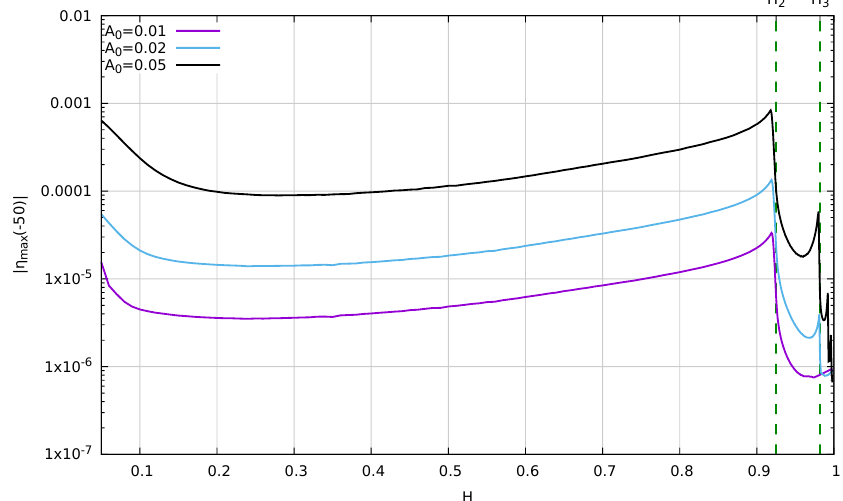
Figure 13 . Maximal radiation amplitude j (cid:17) max ( x ) j , where (cid:17) ( x; t ) = (cid:30) ( x; t ) (cid:0) (cid:30) 1 ( x ) is the deviation of the (cid:12)eld from its static value, at x = (cid:0) 50 for the kicked initial conditions (cid:30) ( x; 0) = (cid:30) 1 ( x ), (cid:30) t ( x; 0) = A 0 ! B (cid:17) B ( x ) as a function of H , for three di(cid:11)erent values of A 0 .